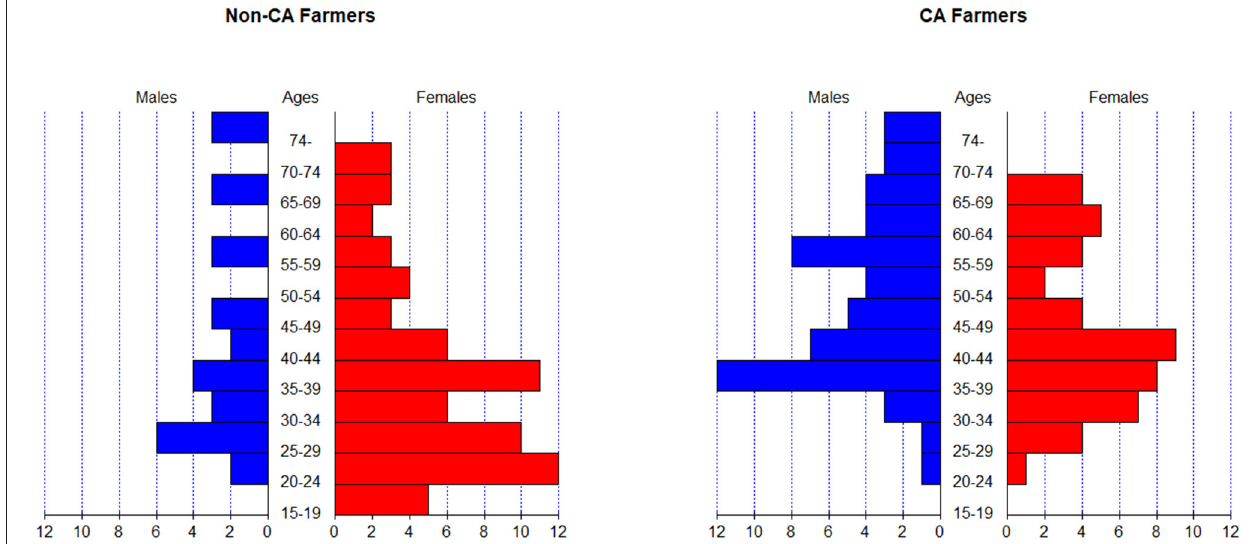
FIGURE 2 | Distribution of ages by respondents for CA and non-CA farmers (Household survey, n = 201).